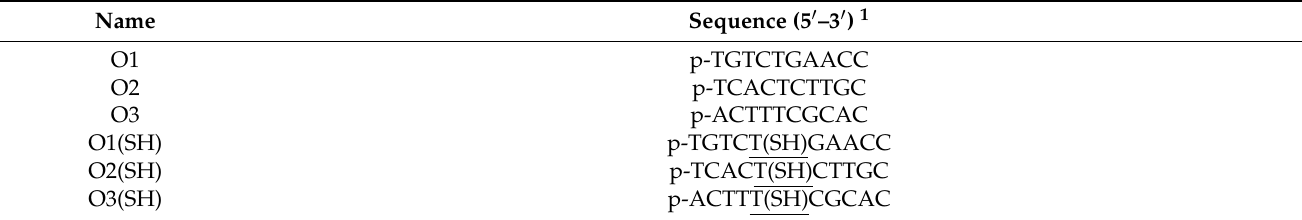
Table 1. Oligonucleotide sequences used for conjugation and